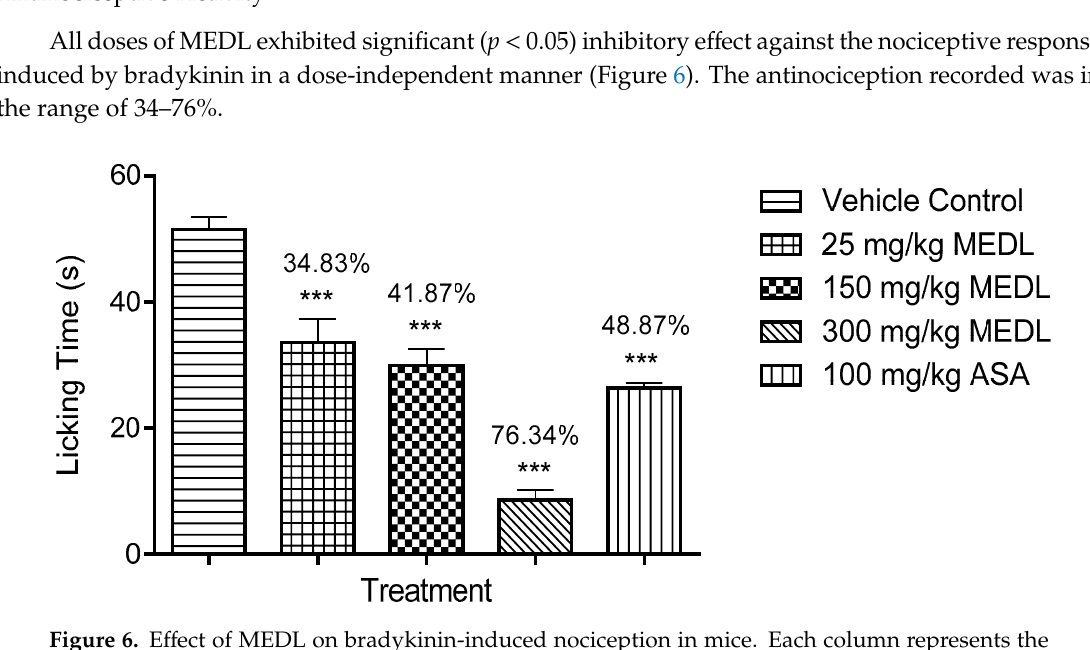
Figure 5. E ff ect of MEDL on glutamate-induced nociception in mice. Each column represents the mean ± SEM of six mice. Statistical analyses were performed using 1-way ANOVA followed by Tukey’s multiple comparisons test. * p ≤ 0.05 and *** p ≤ 0.001 compared to vehicle control group. Values on top of each column denote inhibition.